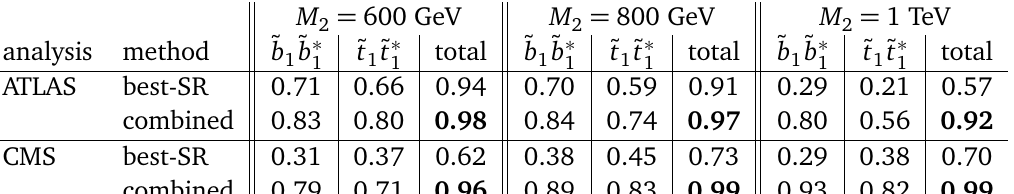
= 1200 GeV and three values of Q 3 ˜ b ∗ ), stop production 1 1 ≥ s